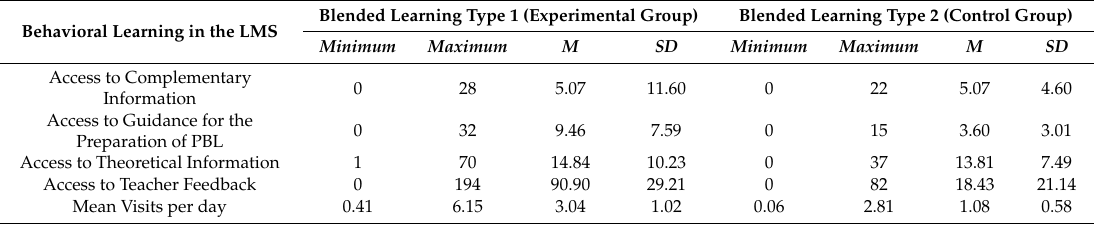
Table A2. Descriptive statistics for Behavioral learning in the